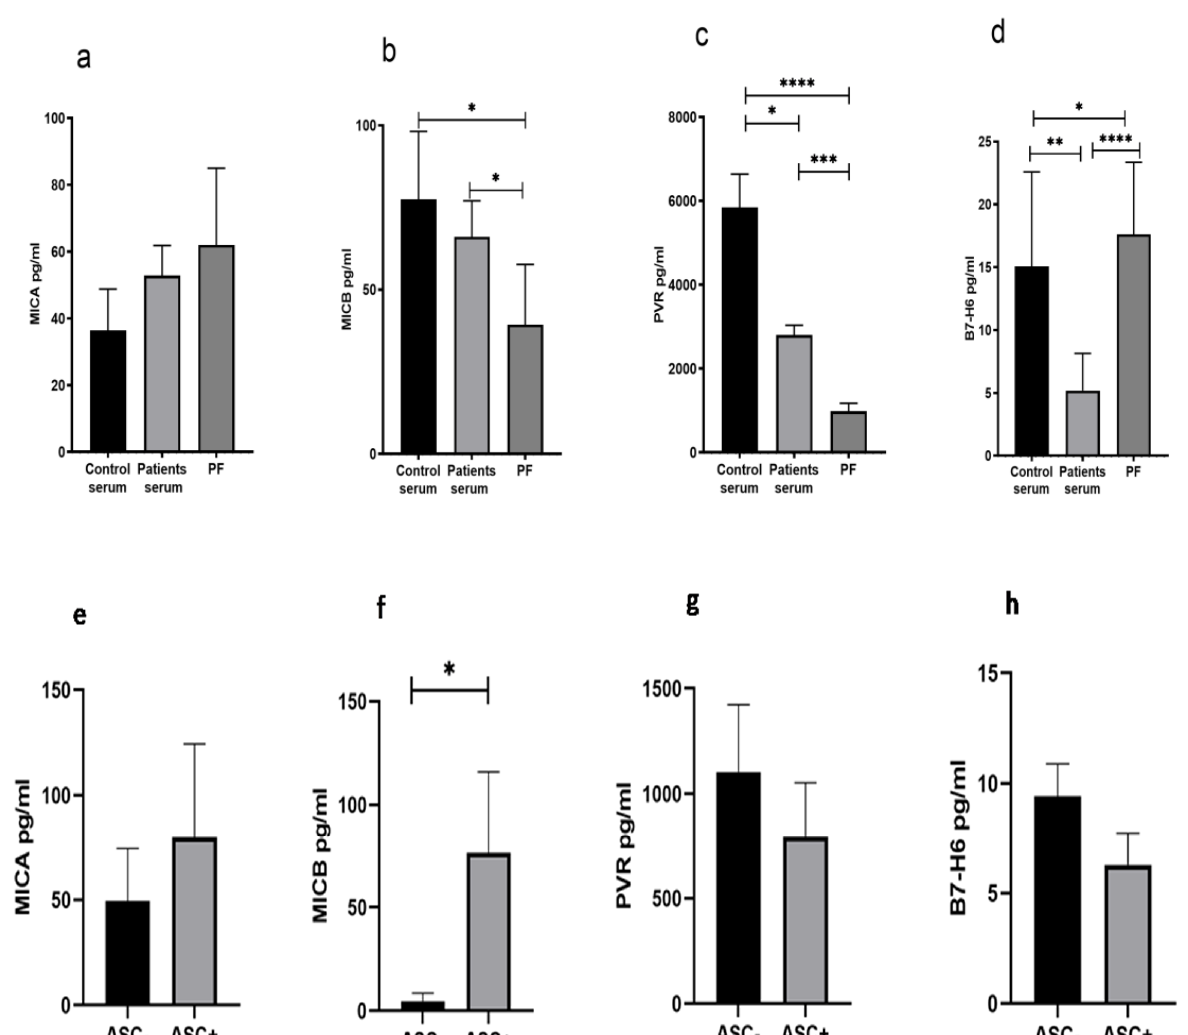
Figure 5. Soluble ligand level ( a – d ) in Control serum, Patient’s serum, and Peritoneal Fluid (PF). Soluble ligands level ( e – h ) in ASC+ and ASC- peritoneal fluid (PF) sample * p < 0.05; ** p < 0.01; *** p < 0.001; **** p < 0.0001.